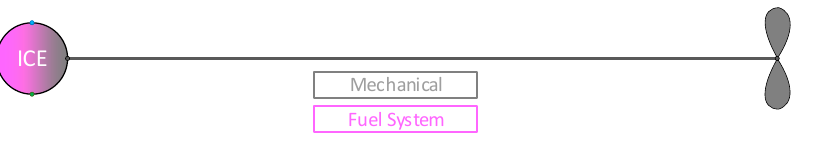
Figure 4. Conventional propulsion system.